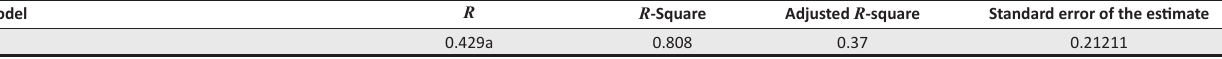
TABLE 5a: Regression analysis ( n = 95).